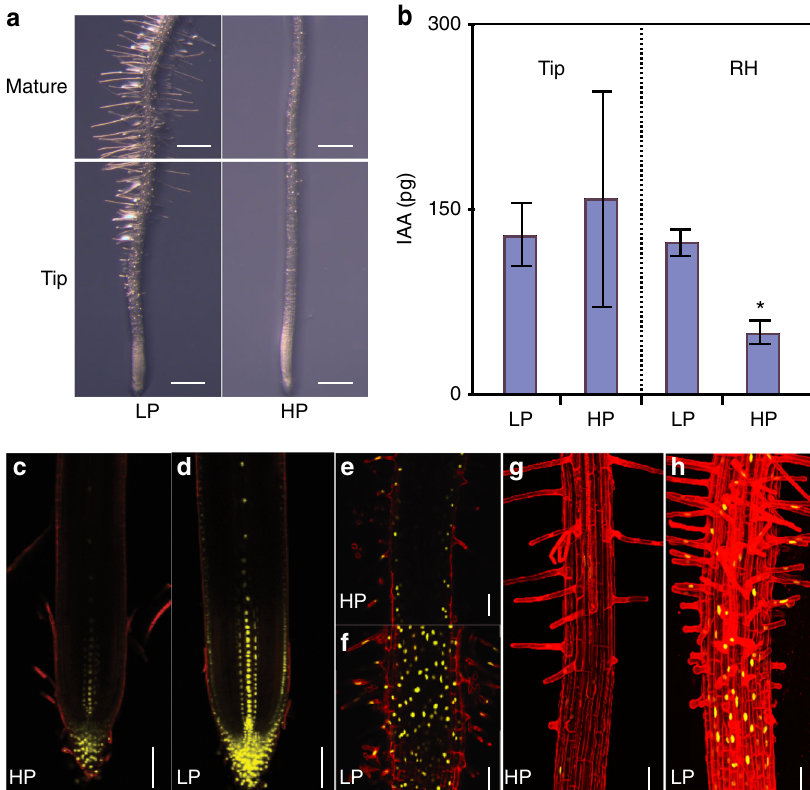
Fig. 1 Root hair elongation is a conserved response to low P in Arabidopsis and results in IAA accumulation in the root tip. a Representative images of 9 day old seedlings grown in 3 µ M (LP) or 312 µ M P (HP). Scale bar = 0.5 mm. b IAA abundance was measured in 9 days old root tips (tip) and root hair region (RH) in Arabidopsis seedlings grown under low (LP) and high P (HP). Error bars represent standard error, N = 4. * Indicates signi fi cant difference ( q - value < 0.05) judged by Student ’ s t -test. c – h . Confocal images of 9 day old Arabidopsis roots expressing auxin response reporter DR5:VENUS (yellow) under low (LP) and high P (HP) showing median ( c , d ) and surface ( e , f ) views. g and h are maximum projections. Propidium iodide was used for counter staining (red). Scale bar = 50 µ